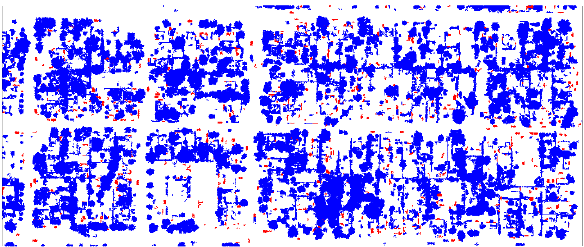
Figure 9. The classification results of planar or smooth surfaces, (a) is the classified ground points, and (b) is the classified building points.